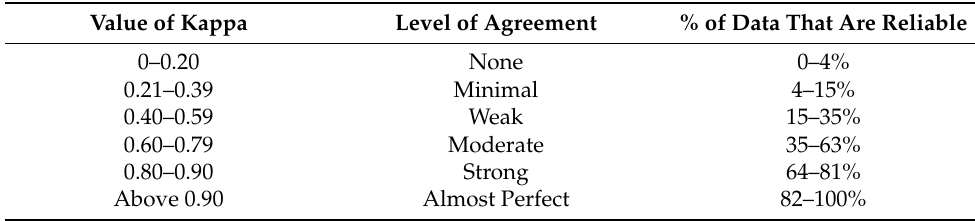
Table 9. Percentage of reliability of data measured with Cohen’s